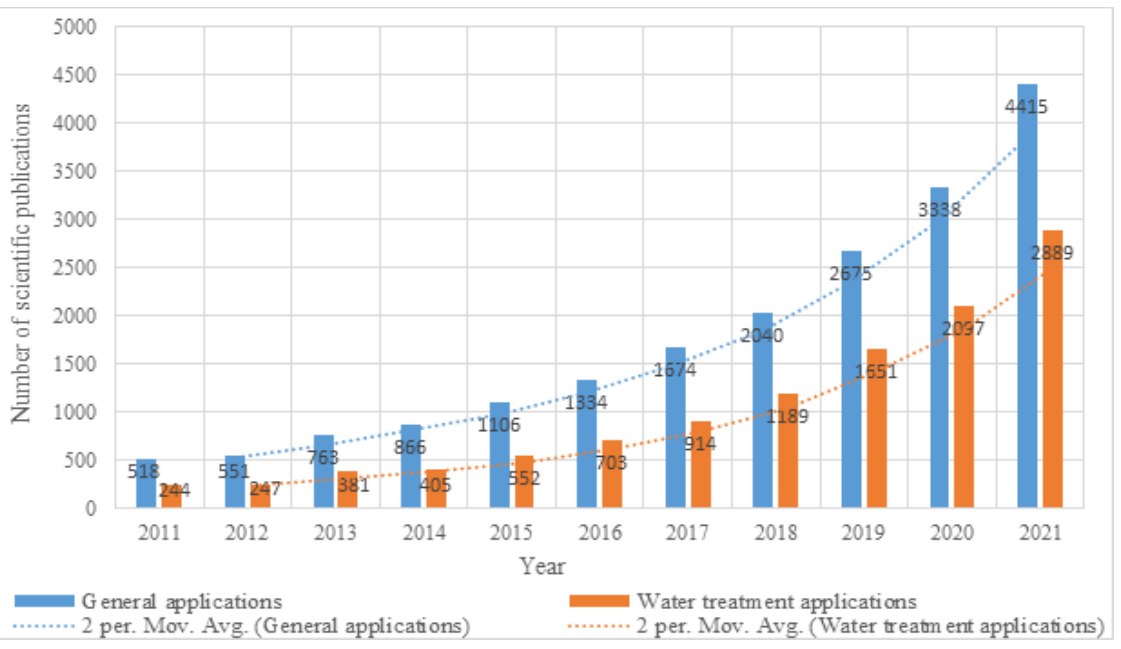
Figure 1. Illustration of the accelerated growth of scientific publications in the past decade related to aerogel and its general and wastewater treatment applications (The search done on 1 November 2022 through Science Direct database).